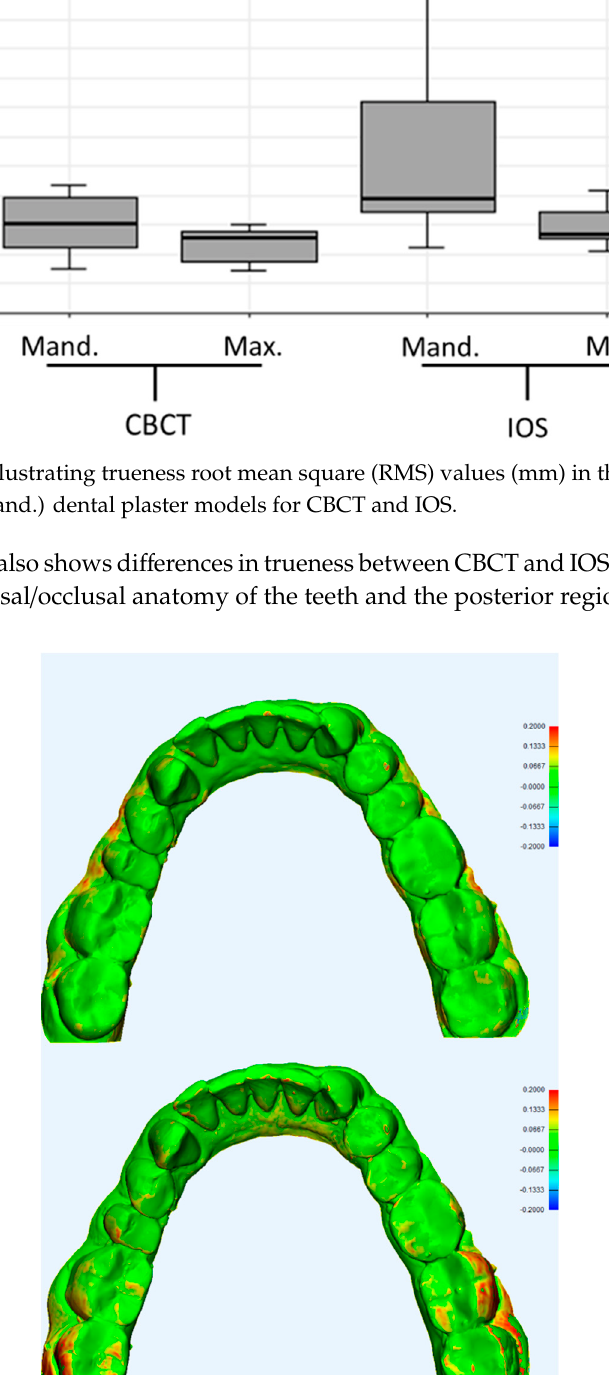
Figure 7. 3D color histogram showing trueness assessment of CBCT scan ( top ) and IO scan ( bottom ), note the higher deviation scores in the posterior regions.